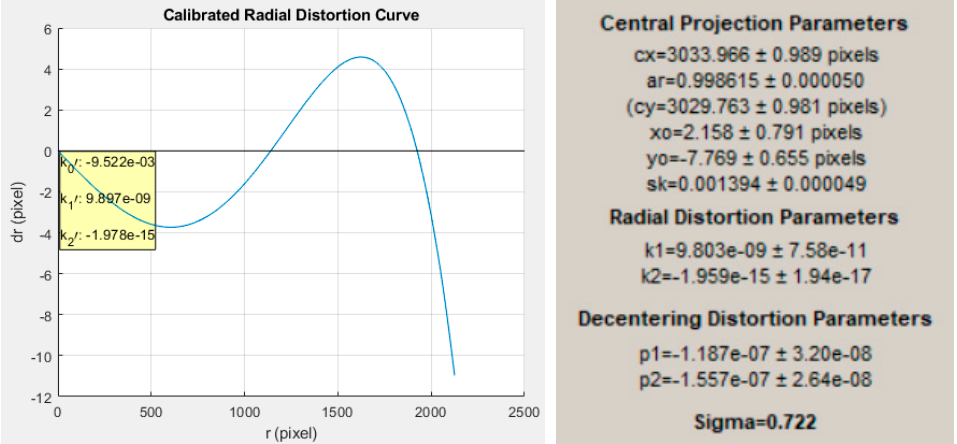
Figure 20. Left: calibrated radial distortion curve. Right: calibrated intrinsic RGB camera parame- ters.